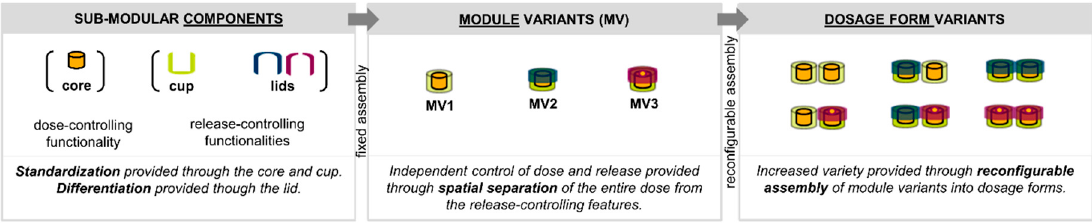
Figure 2. Proposed product concept for independent control of dose and drug release exemplifying the use of composite, reconfigurable drug release to increase release profile variety.